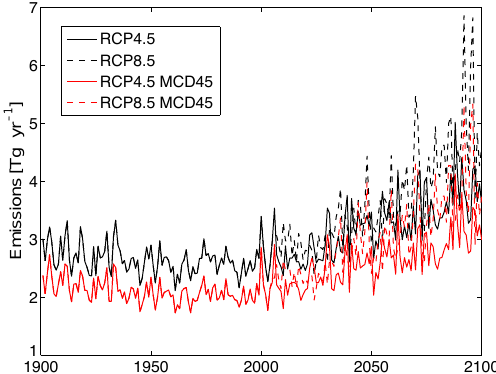
Figure A3. Wildfire carbon emissions for all European regions with the standard SIMFIRE parameterisation compared to runs using SIMFIRE optimised against MCD45 global burned area, for two RCP scenarios and simulations using the MPI global climate